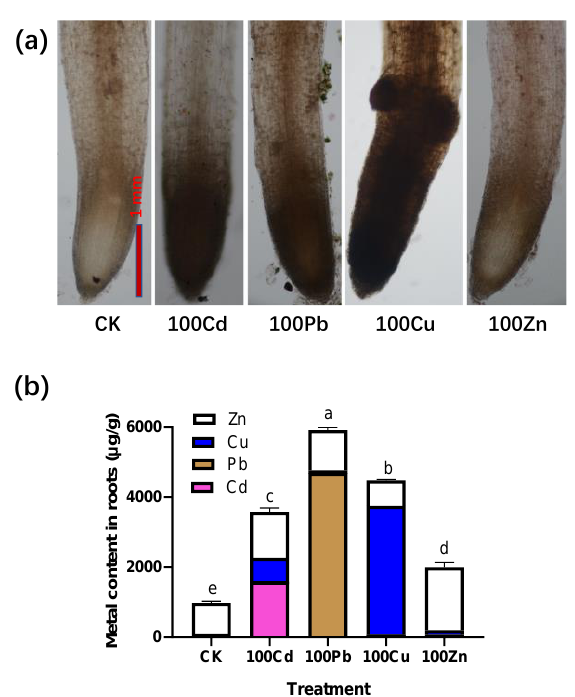
Figure 4. Dithizone staining in root tips ( a ) and metal content in roots ( b ) of M. cordata under control (CK) and 100 µ mol · L − 1 Cd, Pb, Cu, and Zn after 20 days of exposure. Staining experiments were repeated at least five times with similar results. Bar, 1 mm. Values are means ± SEs ( n = 3) of three different experiments. Means denoted by different letters refer to the significant differences ( p < 0.05, Duncan’s test).